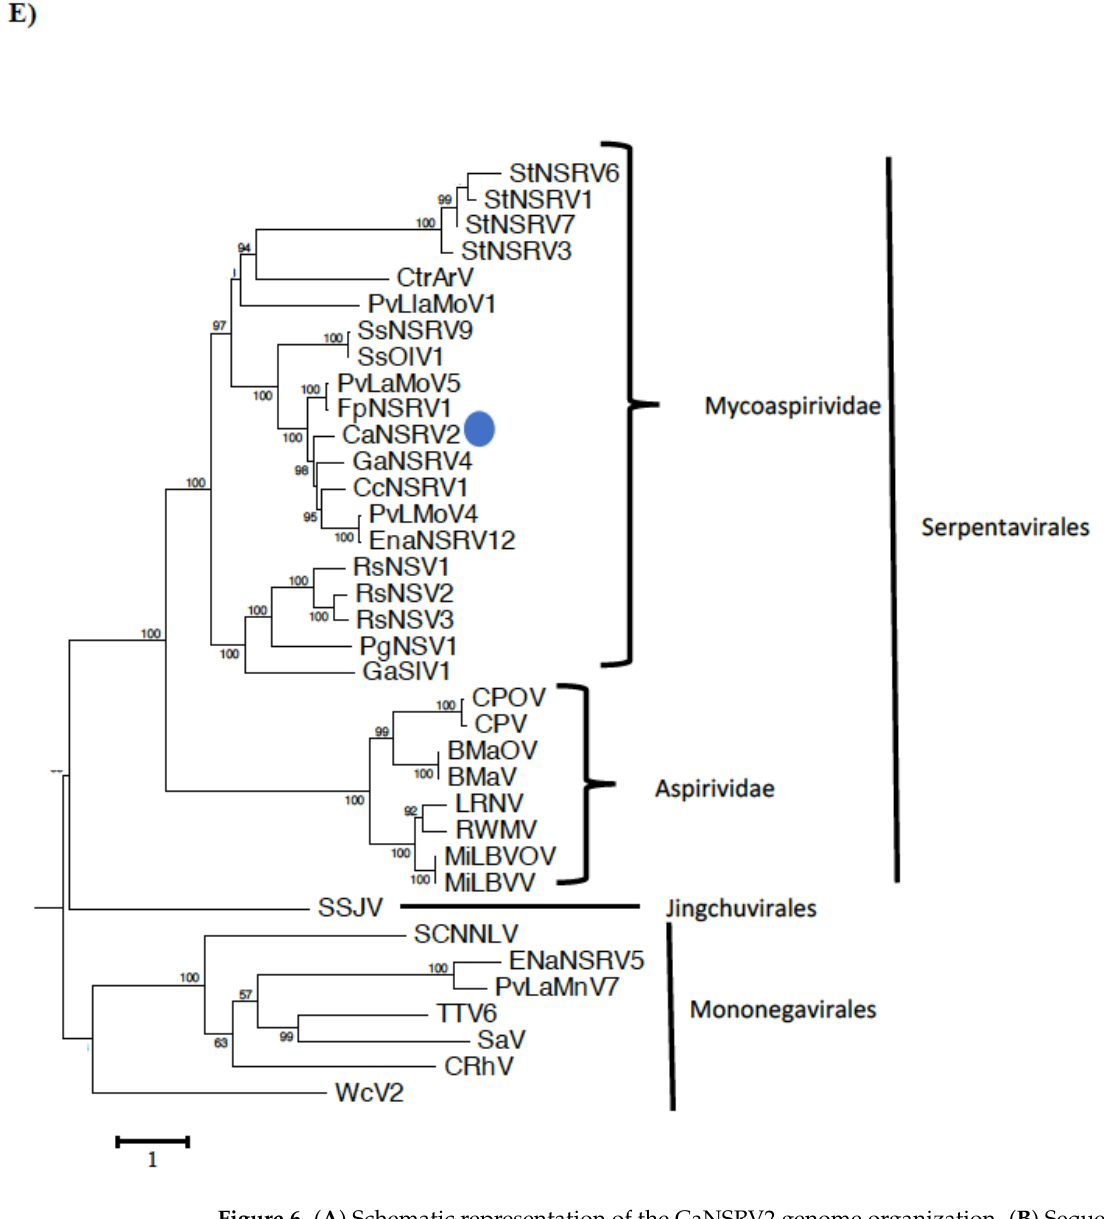
Figure 6. ( A ) Schematic representation of the CaNSRV2 genome organization. ( B ) Sequence align- ments of the terminal ends of CaNSRV2 RNA-1 and RNA-2. ( C ) The multiple alignment of the RdRp sequences of CaNSRV2 and the other related viruses, which indicated four conserved motifs: motif A(SLLLDIEGHNQSMQ), motif B (QLGGIEGWLNPLWTL), motif C (YSDD) and motif D (ADGIRADSTLKRL) and pre-motif A (KEREQKYEARLF). ( D ) Bipartite nuclear localization signals (NLSs) predicted in the RdRp protein of CaNSRV2. ( E ) Alignment and phylogenetic reconstructions were performed using the function “build” of ETE3 3.1.2 [39] as implemented on the GenomeNet (https://www.genome.jp/tools/ete/, accessed on 2 September 2022). Alignment was performed with MAFFT v6.861b with the default options [40]. ML tree was inferred using IQ-TREE 1.5.5, run with ModelFinder and tree reconstruction [41]. The best-fit model, according to BIC was LG+F+R5. Tree branches were tested by SH-like aLRT with 1000 replicates. CaNSRV2 was marked with a circle. The scale bar (lower left) represents the genetic distance of 1 for the phylogenetic tree of RdRps.